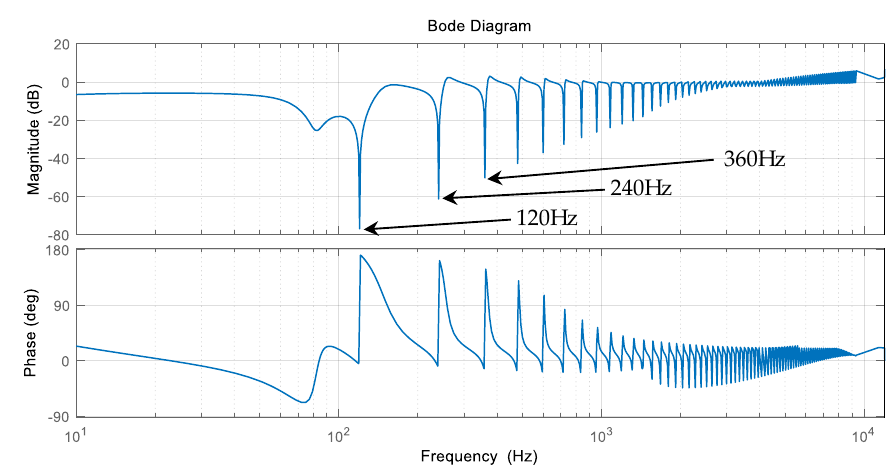
Figure 10. Frequency response of G e ( z ).